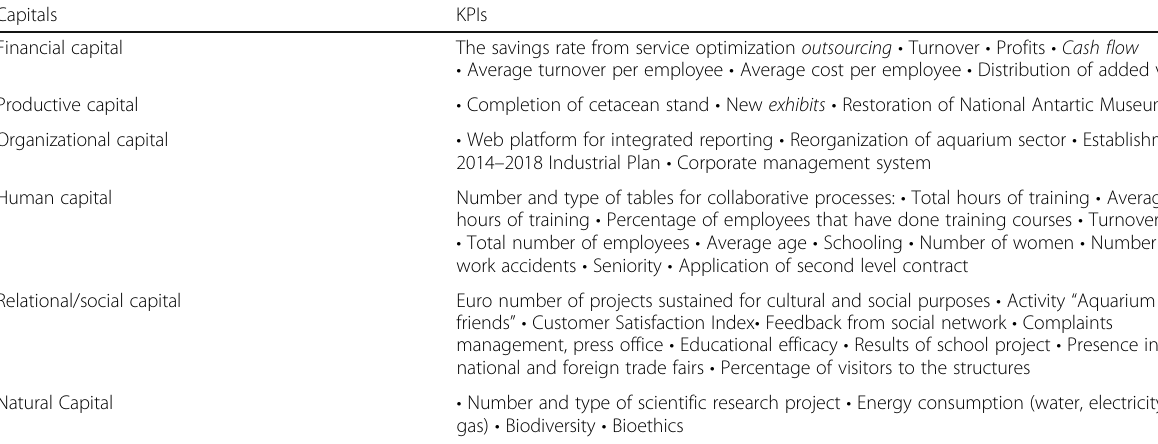
Table 5 Costa Edutainment ’ s KPIs and results on the capitals Capitals